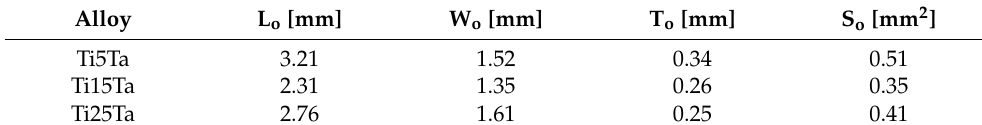
Table 1. Dimensions of one set of samples for tensile tests.